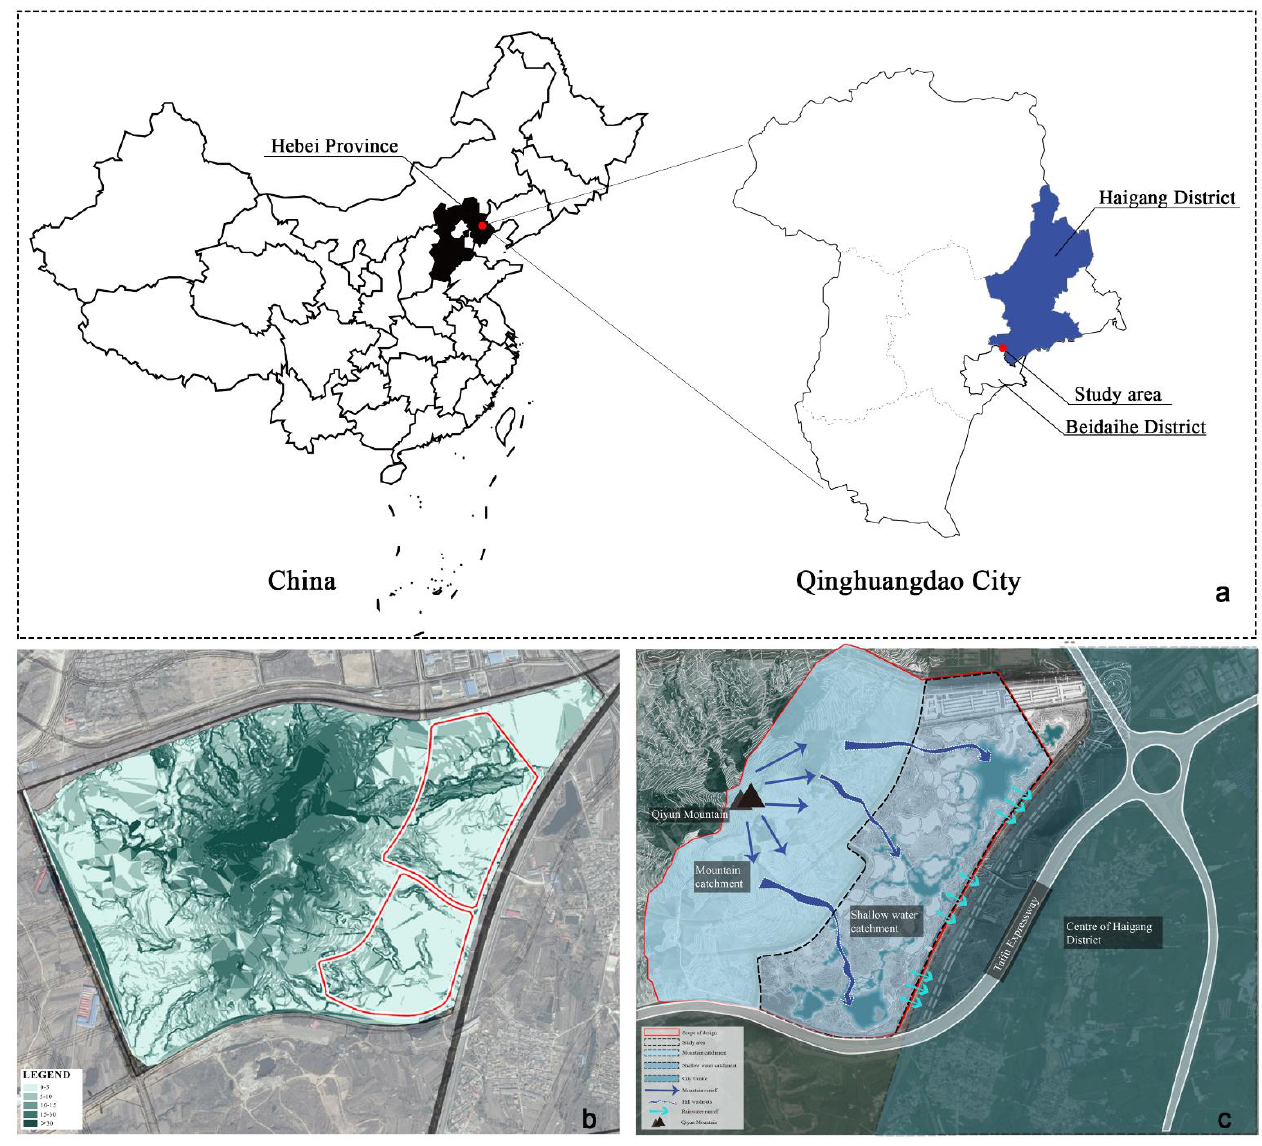
Figure 2. ( a ) Geographical location of the study area; ( b ) Slope of the study area; ( c ) Direction of water flow of the study area.